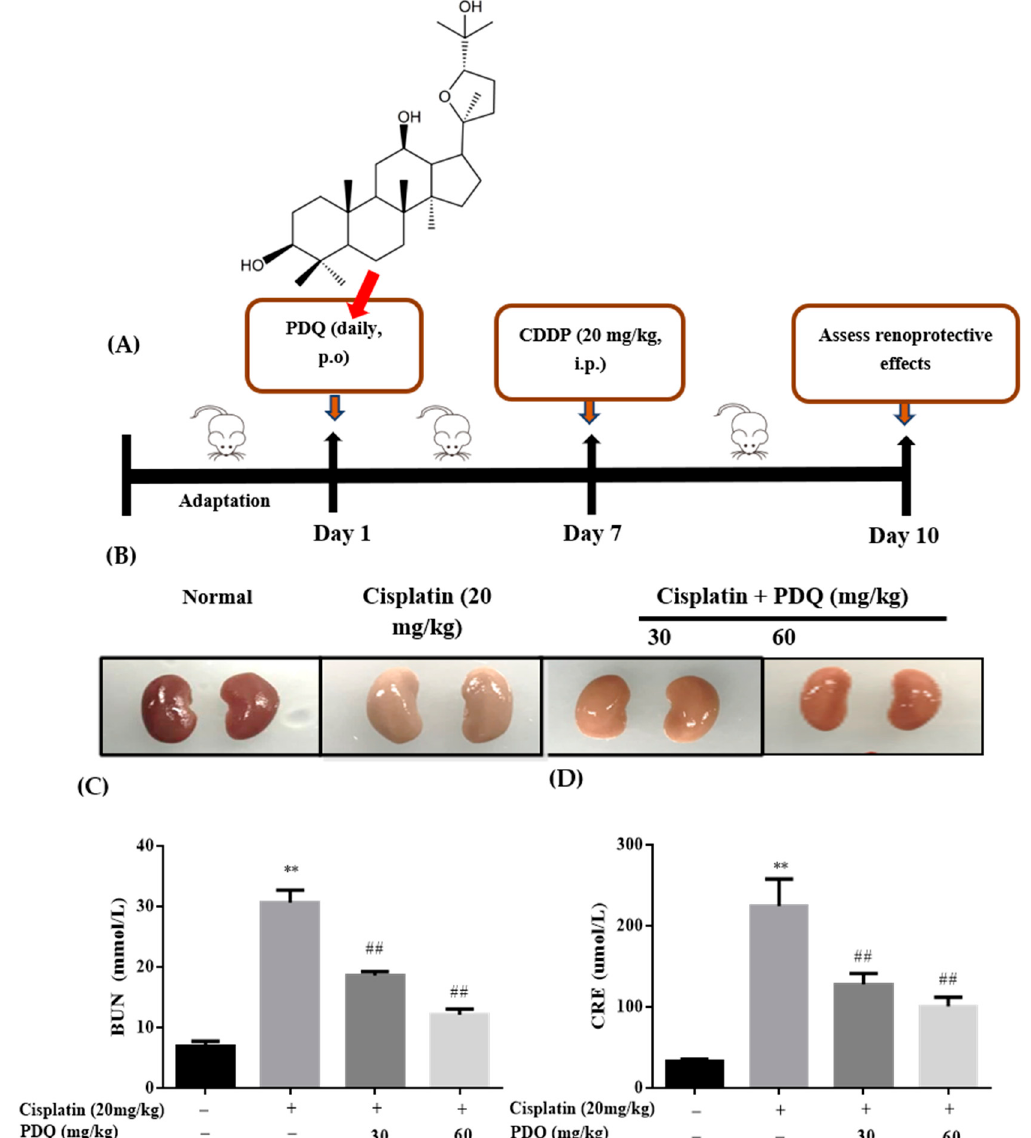
Figure 1. Experiment design ( A ); morphological change in kidney tissues ( B ); effects of PDQ on the levels of blood urea nitrogen (BUN) ( C ) and creatinine (CRE) ( D ). n = 8, ** p < 0.01 vs. normal group; ## p < 0.01 vs. cisplatin group.